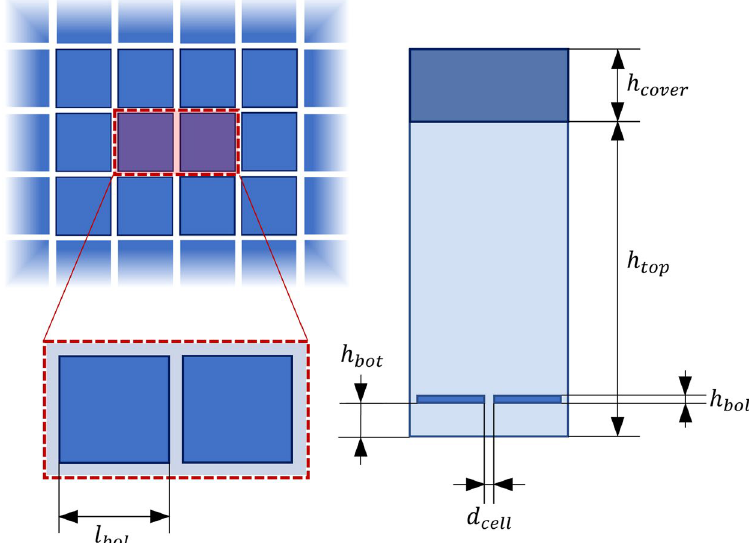
Figure 1. Sketches of the top and front views of the simulated unit cell. The values of the geometric parameters are: l bol = 25 μ m, h bol = 1 μ m, d cell = 1 μ m, h top = 97 μ m, h bot = 2 μ m and h cover = 10 μ